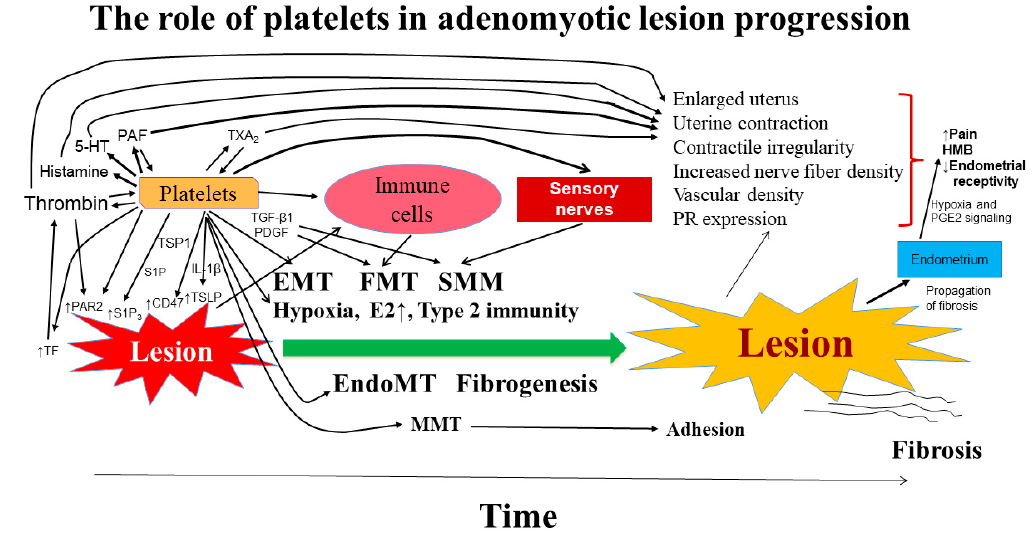
Figure 1. Schematic illustration of the roles of platelets in the progression of adenomyotic lesions. The arrows indicate the crosstalk between adenomyotic lesions and other cells in the lesional mi- croenvironment. Many cells in the lesional microenvironment interact with adenomyotic lesions, and cytokines/chemokines, growth factors, and neuropeptides released by these cells, such as platelets (anuclear), immune cells (such as macrophages and lymphocytes), and sensory nerve fibers can accelerate the development of adenomyotic lesions. Type 2 immunity also promotes fibrogenesis of adenomyotic lesions. Histamine, 5-HT, PAF, TXA 2 and thrombin derived from activated platelets may also enhance uterine contractility. The upward arrows indicate upregulation/overexpression or increase. The directional arrows mean “lead to” or “result in”. Abbreviations used: 5-HT = 5-hydroxytryptamine, serotonin; E2 = 17 β -estradiol; EMT = epithelial–mesenchymal transition; EndoMT = endothelial-mesenchymal transition; FMT = fibroblast-to-myofibroblast transdifferentiation; HMB = heavy menstrual bleeding; MMT = mesothelial-mesenchymal tran- sition; PR = progesterone receptor; SMM = smooth muscle metaplasia; PAF = platelet activat- ing factor; PAR2 = protease activated receptor 2; PGE2 = prostaglandin E2; S1P = sphingosine 1-phosphate; S1P 3 = sphingosine 1-phosphate receptor 3; PDGF = platelet-derived growth factor; TGF- β 1 = transforming growth factor β 1; TXA2 = thromboxane A2; TSLP = thymic stromal lym- phopoietin; TSP1 = thrombospondin-1; TF = tissue factor.